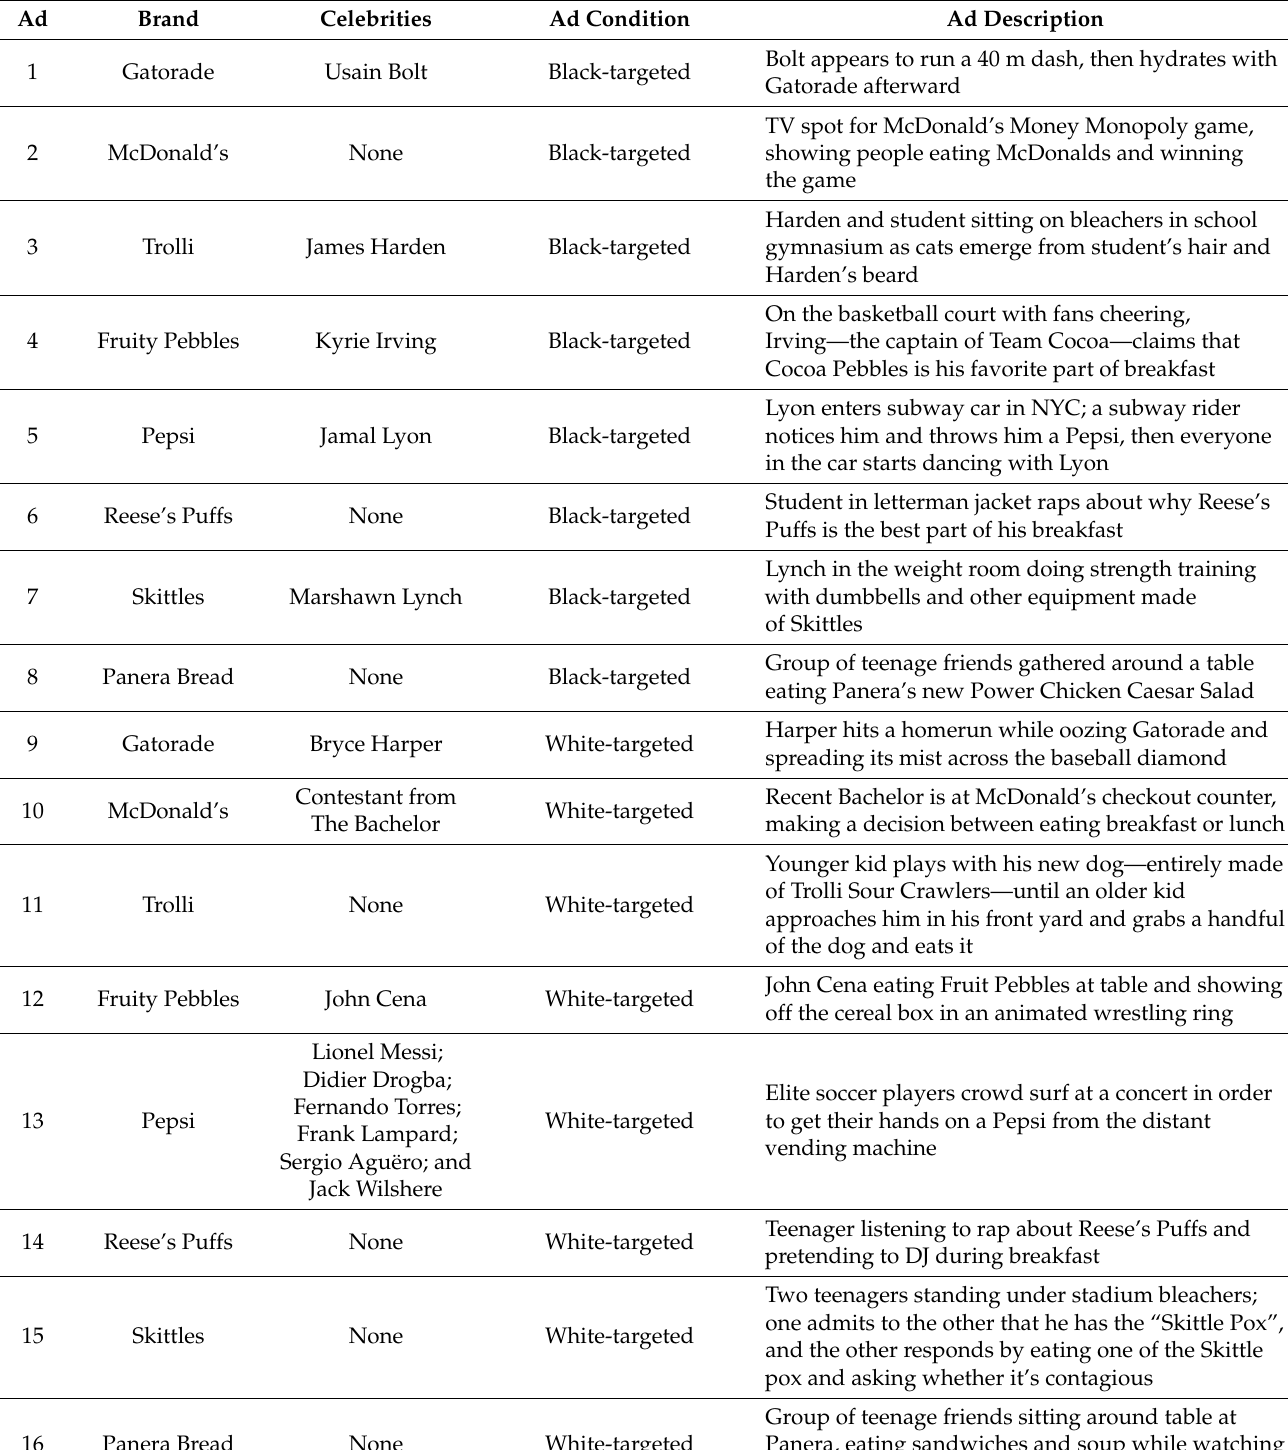
Table 1. Description of ad stimuli and featured